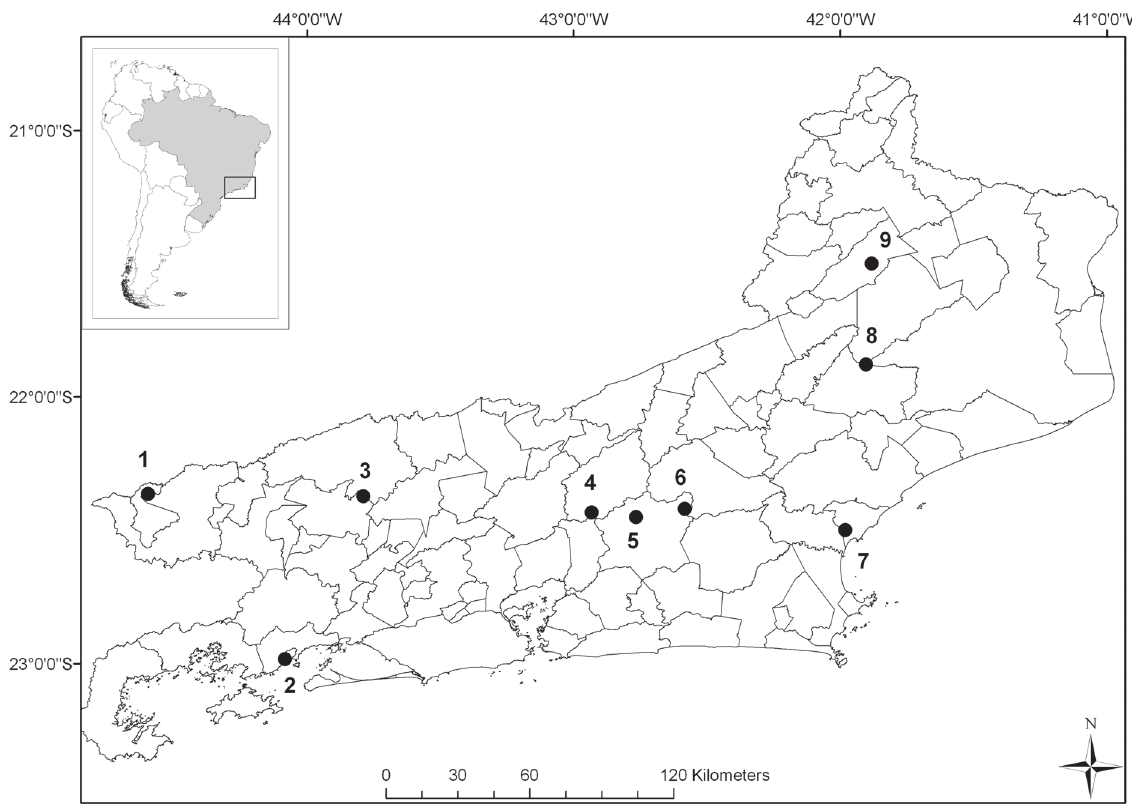
Figure 1. Map of the state of Rio de Janeiro showing the nine localities sampled in this study. Legend: 1) Marimbondo Farm, 2) Rio das Pedras Ecological Reserve, 3) Santo Antônio da Aliança Farm, 4) Paraíso State Ecological Station, 5) Guapiaçú Ecological Reserve, 6) Vale da Pedra Branca Farm, 7) Morro São João, 8) Desengano State Park, 9) Esmeralda